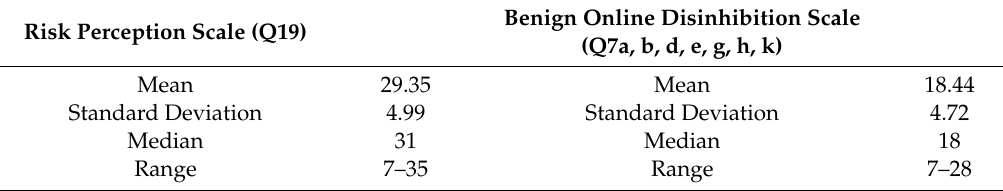
Table 4. Risk Perception and Benign Disinhibition